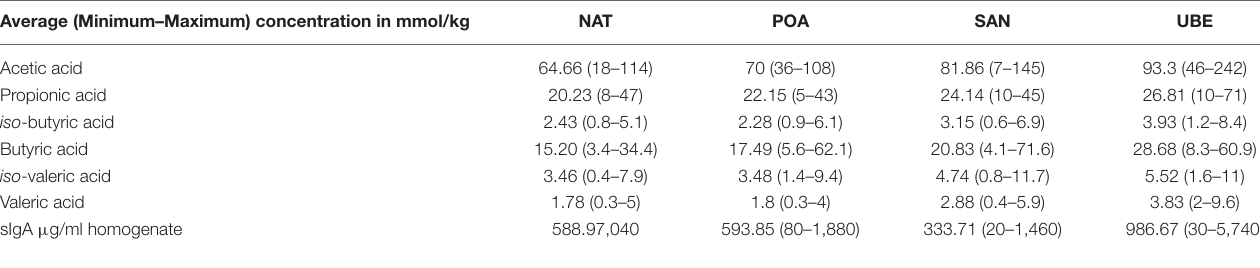
TABLE 2 | Average (minimum–maximum) fecal short chain fatty acid concentrations in mmol/kg of fecal material measured in subjects from the four sample sites. Average (Minimum–Maximum) concentration in